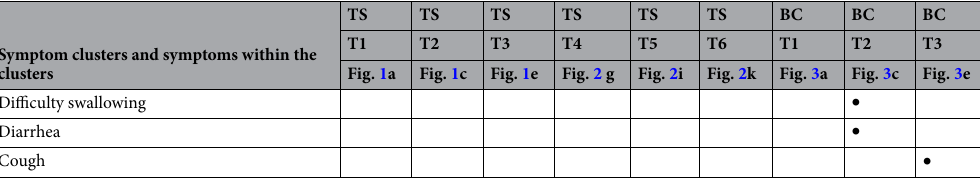
Table 1. Symptoms included in each of the symptom clusters derived from network analyses for the total sample and patients with breast cancer. The evaluation of the consistency of the symptoms was done within each cluster across the samples and across time as the total number of symptoms at a specific time point/total number of symptoms in that cluster across samples and time. Abbreviations: BC = breast cancer, T = time, and TS = total sample.